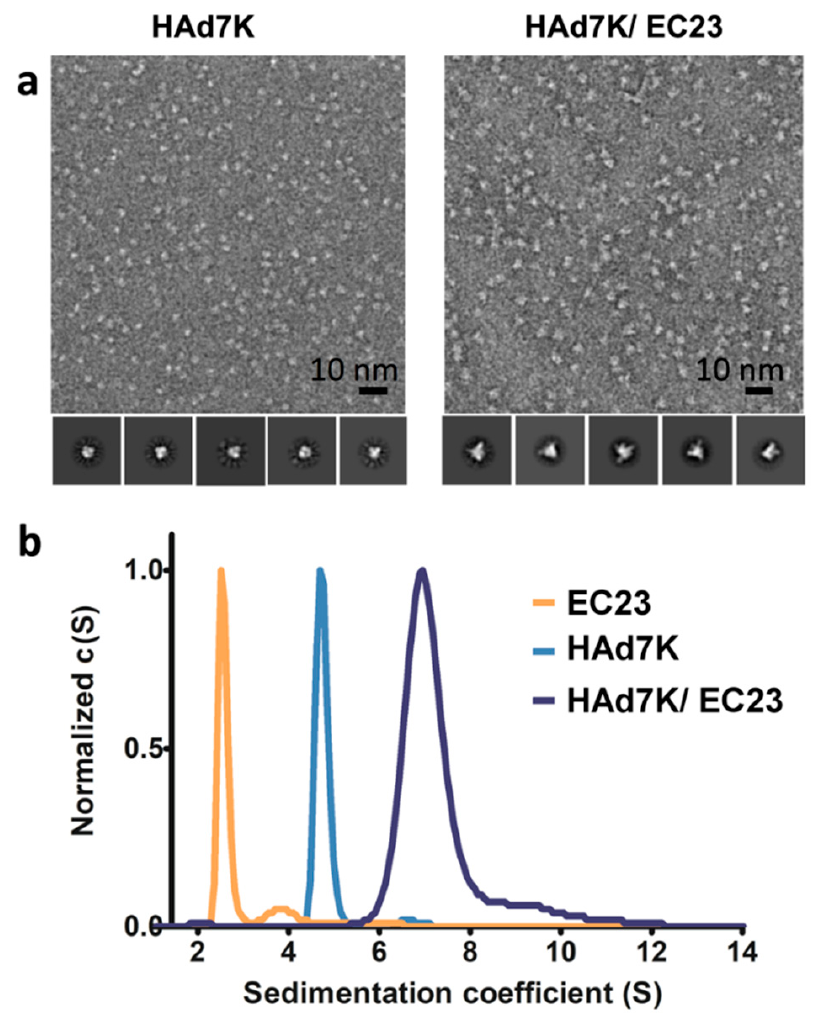
Figure 2. ( a ) Negative-staining electron microscopy analysis. Left: electron micrograph of HAd7K. Right: electron micrograph of HAd7K in complex with EC23. Representative class averages are shown